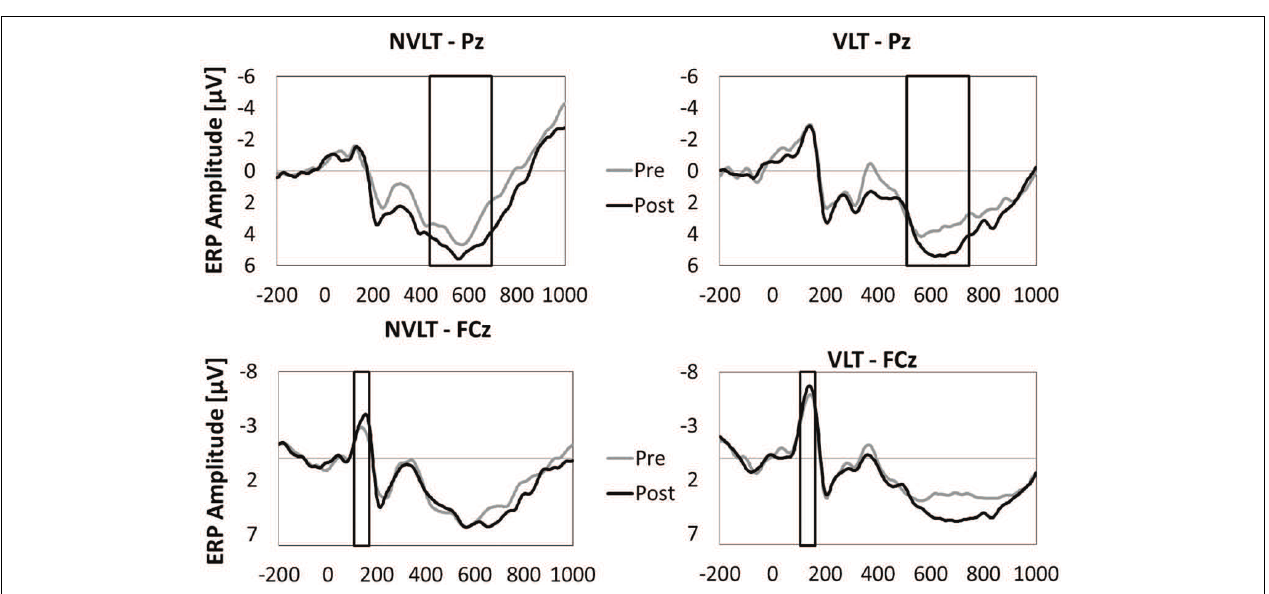
FIGURE 6 | Means of ERP amplitudes (FCz and Pz) during the encoding phase of the non-verbal learning task (NVLT) and the verbal learning task (VLT), for the pre- and post-measurement of stroke patient UG20. The analyzed latency windows are marked with rectangles.